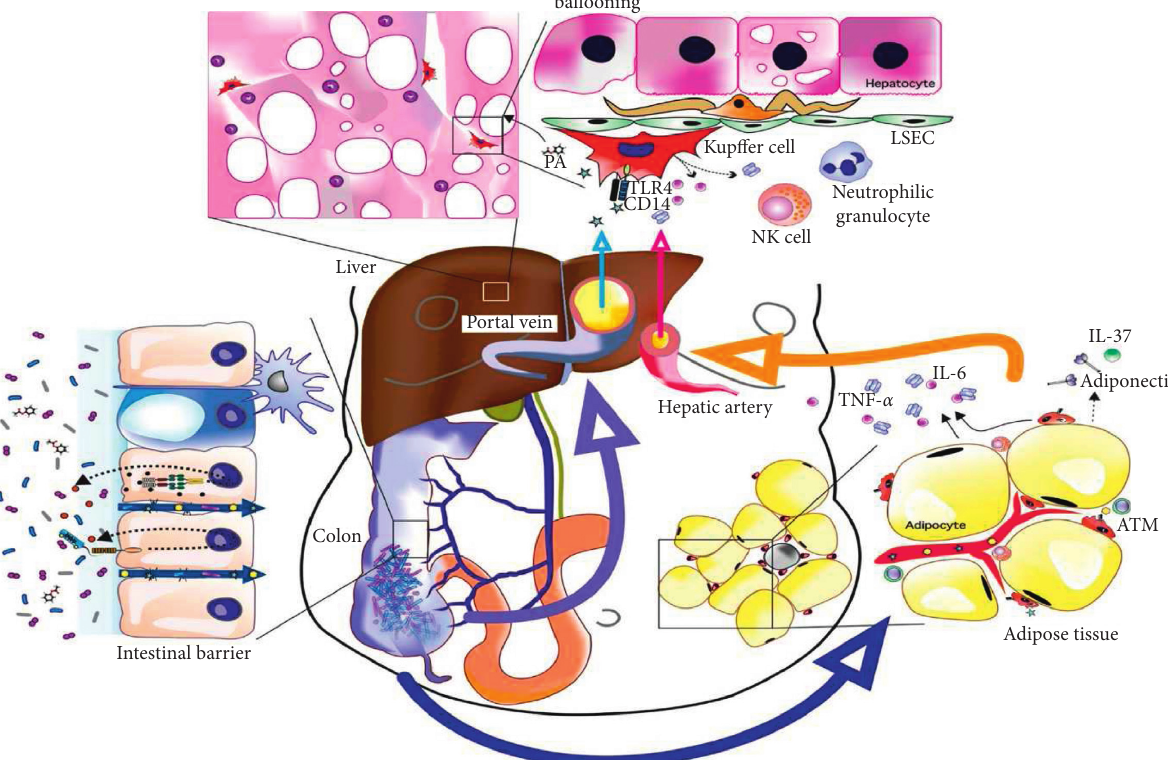
Figure 1: Multiple parallel hits hypothesis in nonalcoholic fatty liver disease (reproduced with permission from [11]).